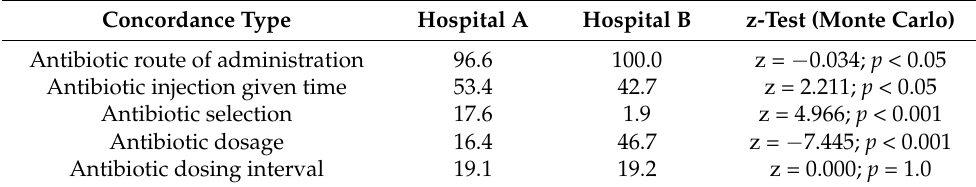
Table 4. The percentage concordance to ASHP Therapeutic